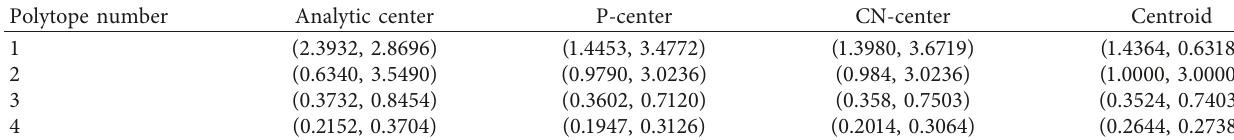
Table 2: A numerical comparison between coordinates of analytic center, P-center, CN-center, and